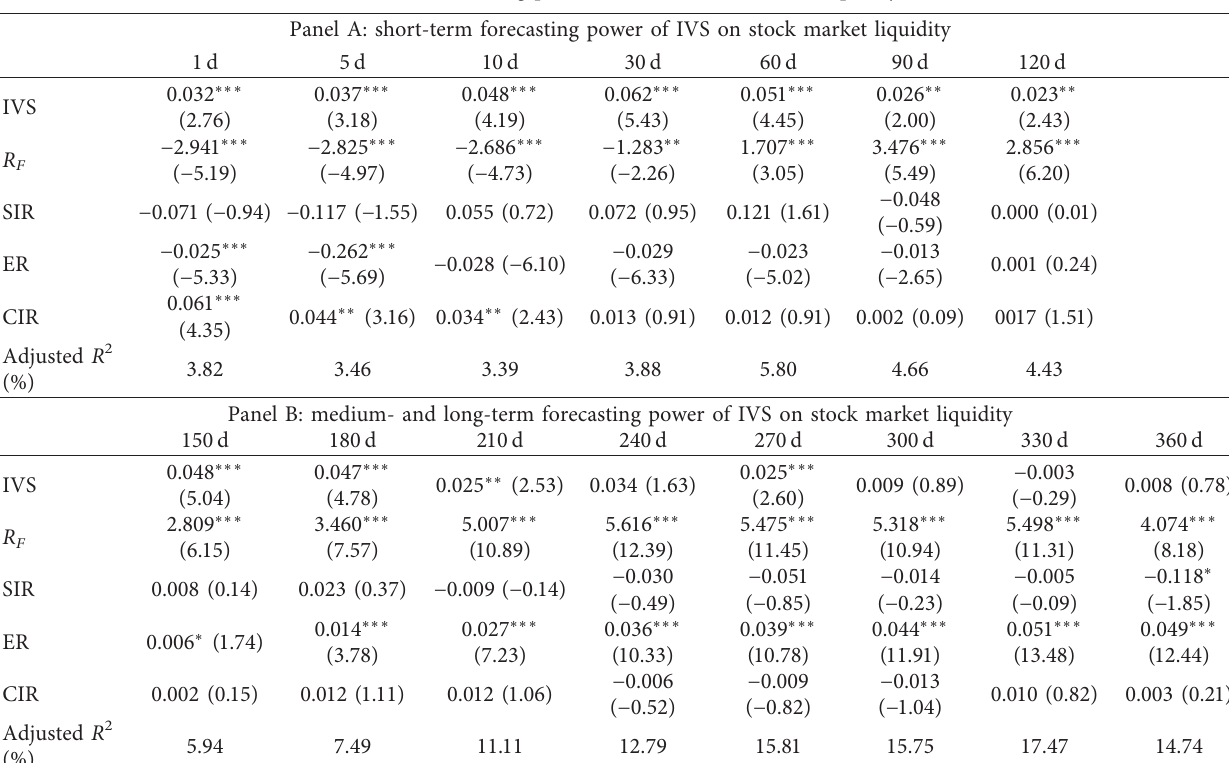
Table 5: Forecasting power of IVS on stock market liquidity. Panel A: short-term forecasting power of IVS on stock market